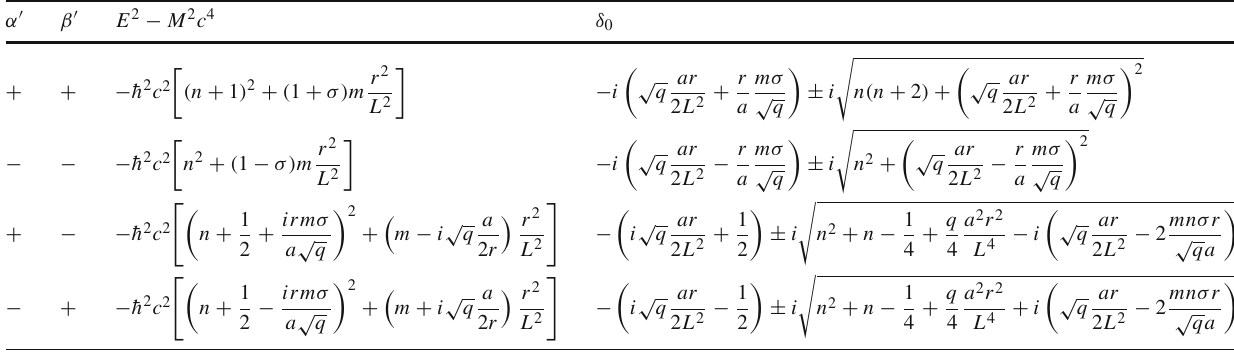
Table 2 The asymptotic parameter δ 0 at u = 0 for constant field scenario